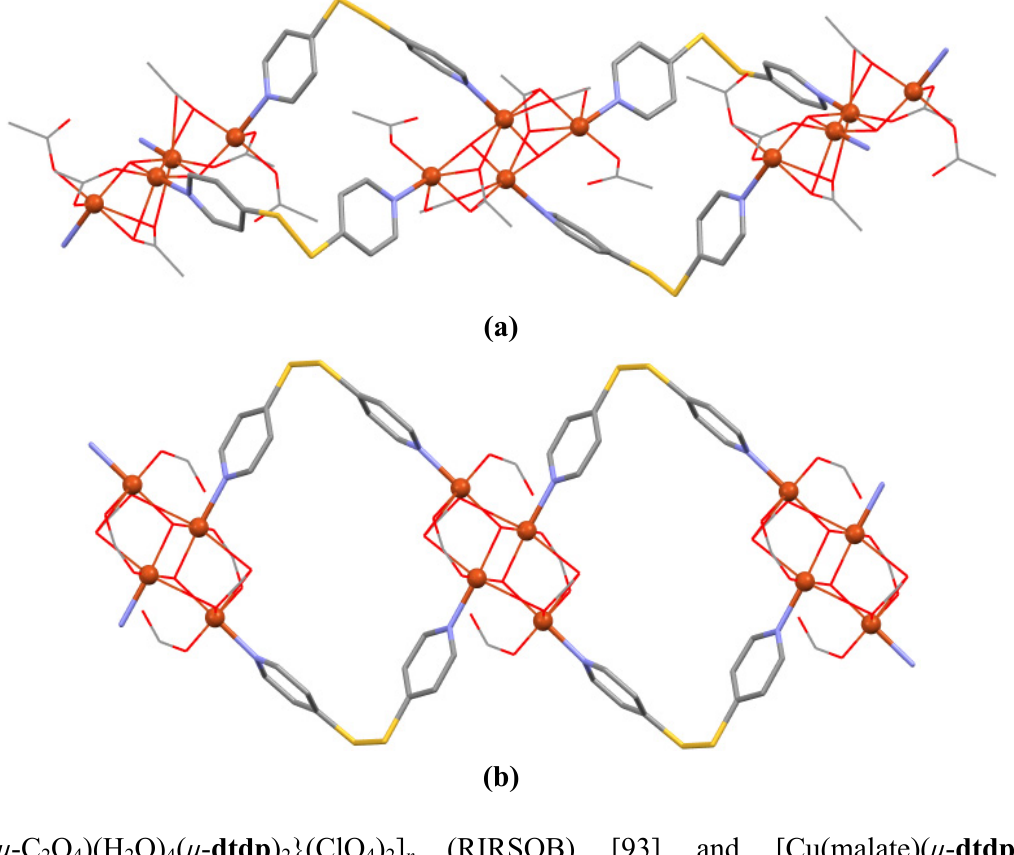
(CH COO) ( μ -OH) ( μ - dtdp ) ] 4 3 6 3 2 2 n